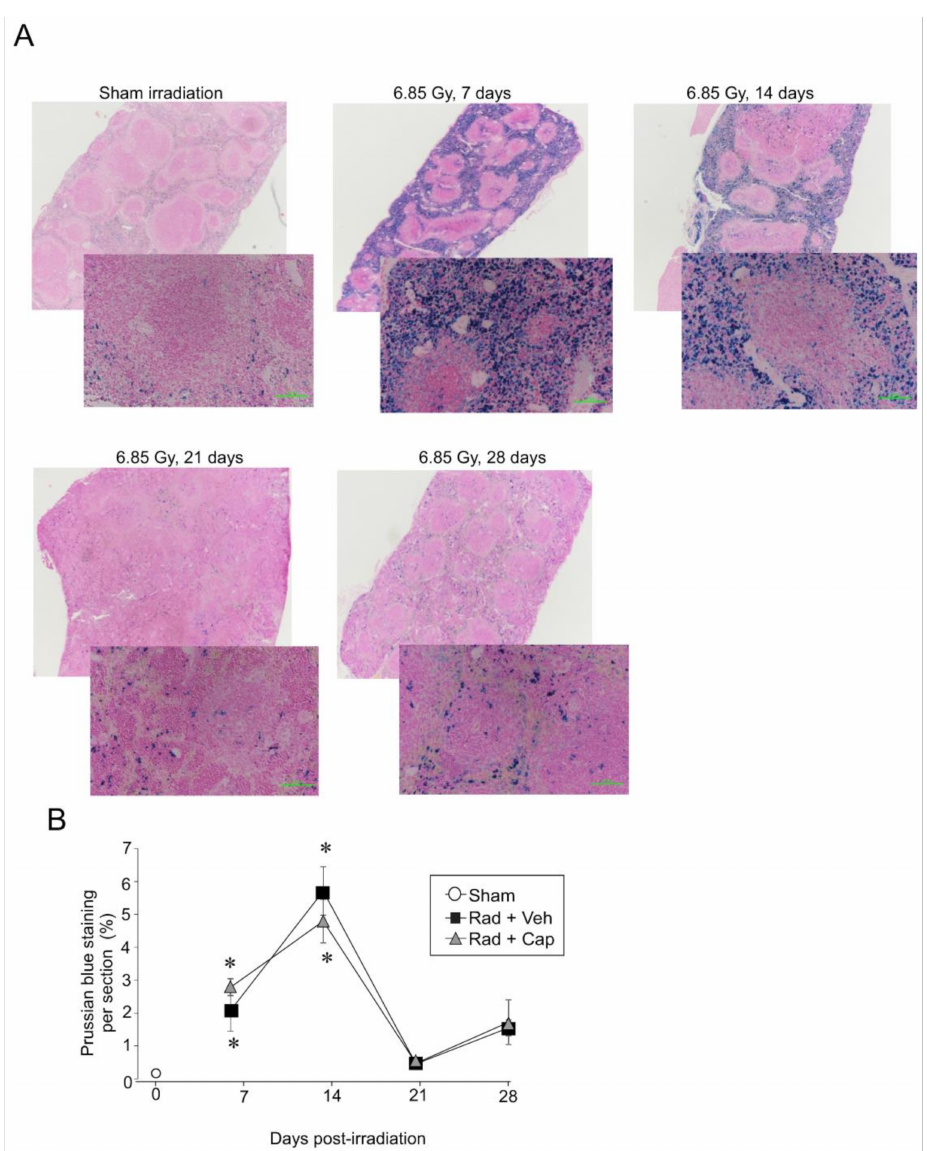
Figure 2. Total body irradiation is associated with increased Fe 3+ deposition in the spleen. C57BL/6 mice were exposed to 6.85 Gy total body irradiation. Animals received vehicle (drinking water alone) or captopril in the drinking water on days +2–+16 post-irradiation. At the indicated time points, mice were euthanized, and spleen tissue was obtained for histology. ( A ) Spleen sections were stained with Prussian blue to visualize Fe 3+ content from the animal receiving vehicle. Whole spleen images are shown from the Ziess Axioscan. Representative images from 3 separate slides are shown in the high-powered (30 × ) magnification. ( B ) Prussian blue staining was quantified. Graph shows means ± SEM from n = 4 animals per group; * indicates p < 0.05 from control (sham irradiated)